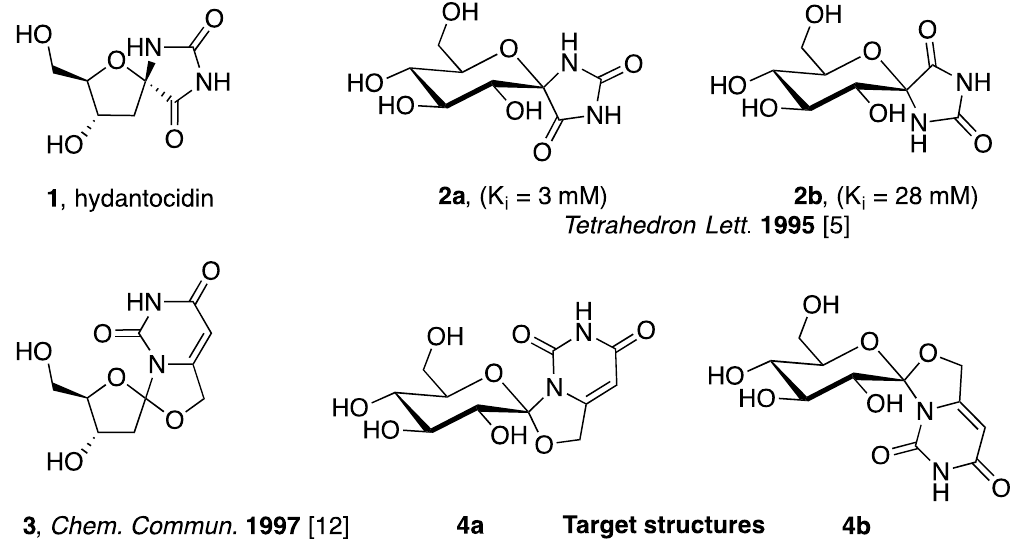
Figure 1. Natural and synthetic anomeric spironucleosides.